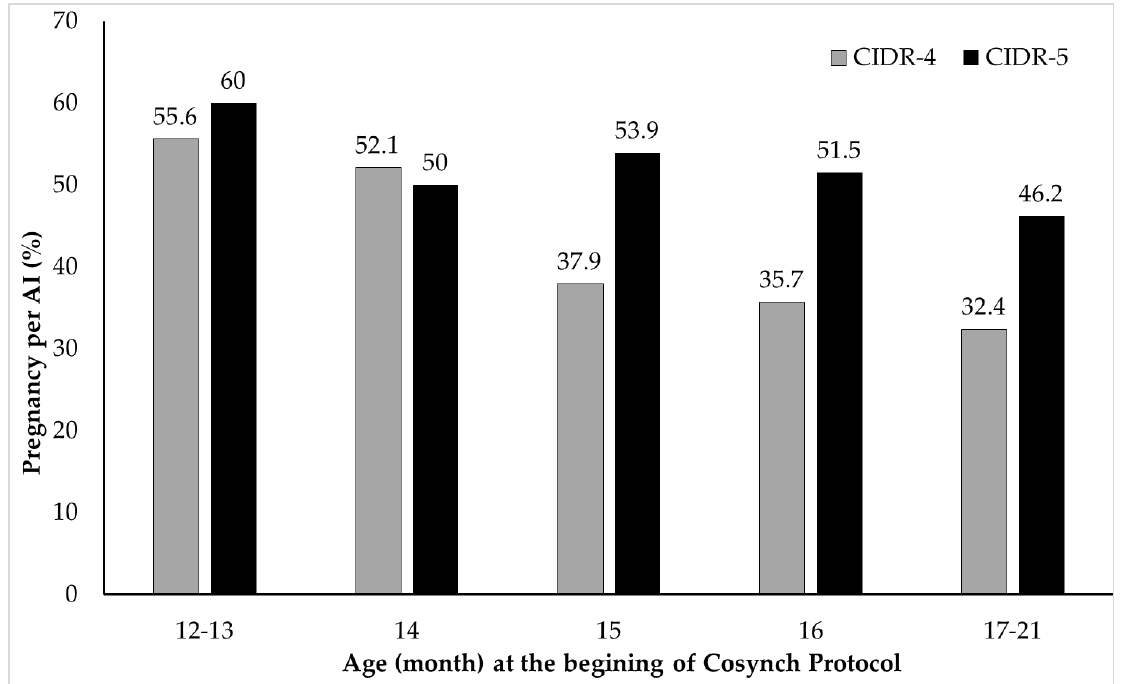
Figure 4. Significant ( p < 0.01) interaction effect of treatment (CIDR-4 vs. CIDR-5) by age of heifer indicates lower pregnancy per AI in CIDR-4 (gray bars) group as heifers age increased compared to CIDR-5 (black bars) group.